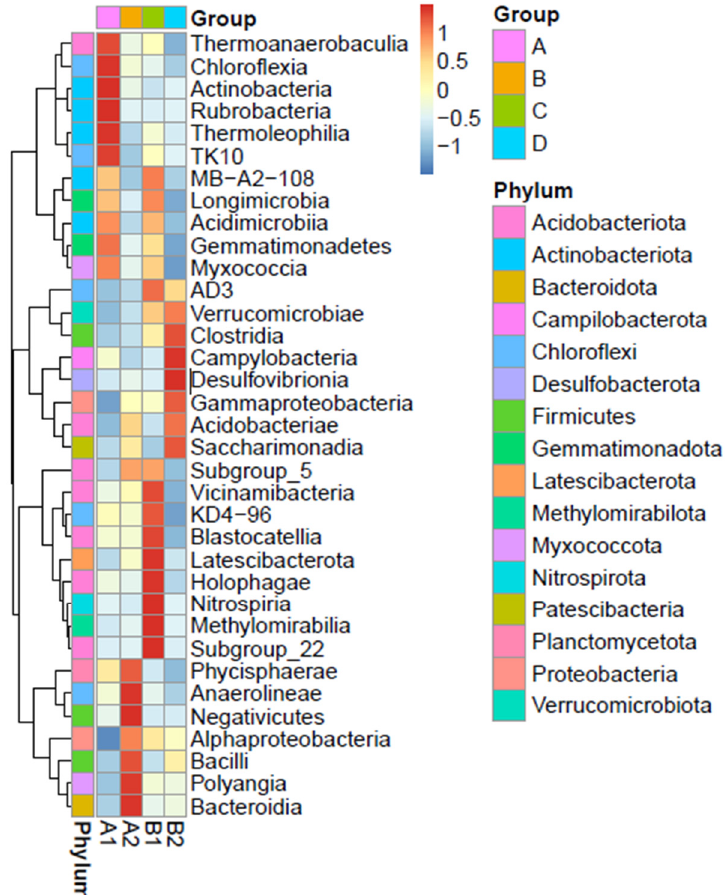
Figure 4. Taxonomic abundance cluster heatmap. Plotted by sample name on the X-axis, and the Y-axis represents the genus. The absolute value of ‘z’ represents the distance between the raw score and the mean of the standard deviation. ‘Z’ is negative when the raw score is below the mean and vice versa (A1, thermophilic of Harmanli site; A2, mesophilic of Harmanli site; B1, mesophilic of Yasno pole site; B2, thermophilic of Yasno pole site).